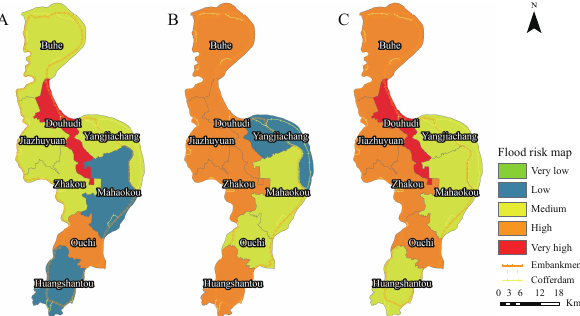
Fig. 11. Integrated flood risk maps for the Jingjiang flood diversion district: (A) flood vulnerability grade map; (B) flood hazard grade map; (C ) flood risk grade